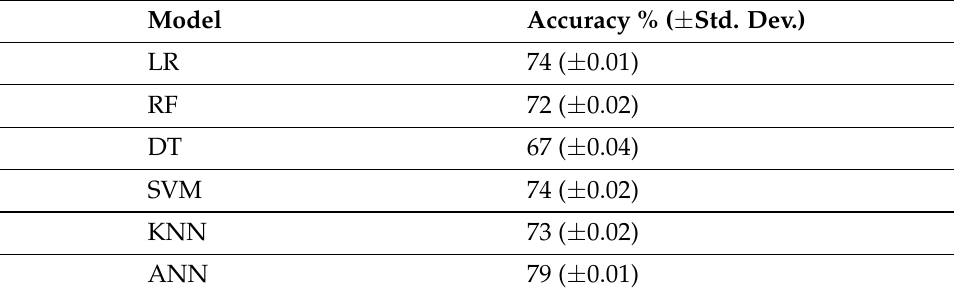
Table 10. Results of 10-fold cross-validation for all